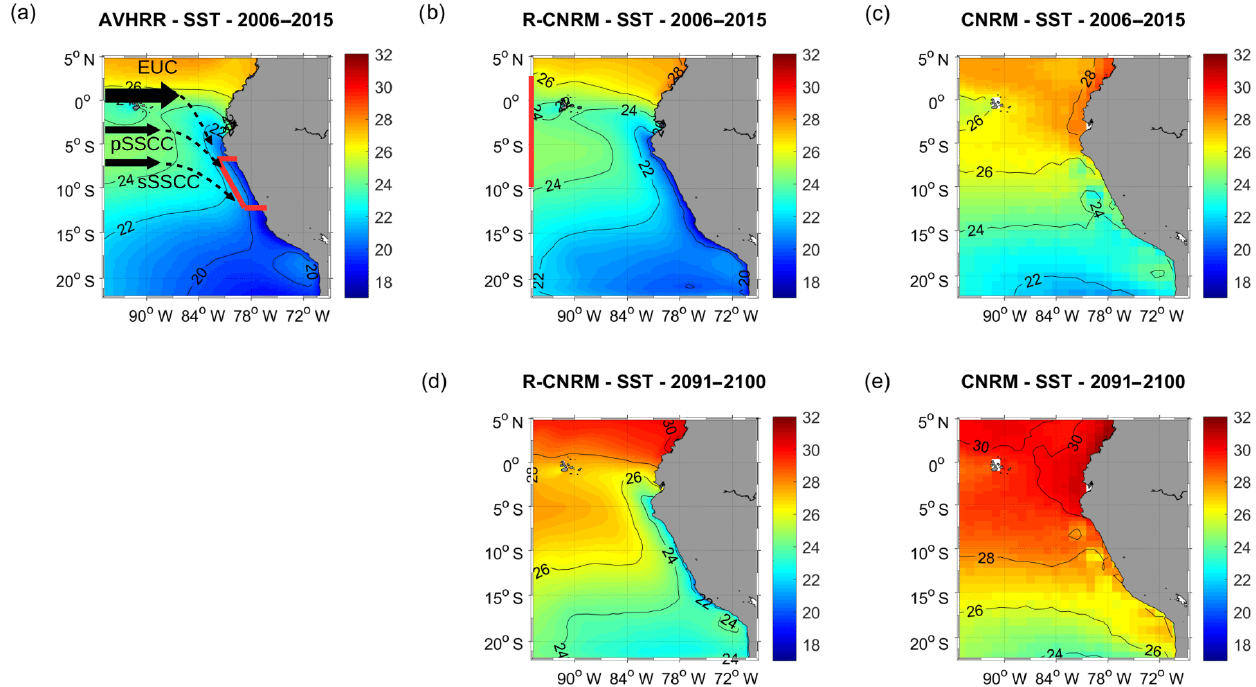
Figure 2. Annual mean SST ( ◦ C) for (a) AVHRR surface observations (2006–2015), (b) R-CNRM (control period, 2006–2015), (c) CNRM (2006–2015), (d) R-CNRM (RCP8.5, 2091–2100), and (e) CNRM (RCP8.5, 2091–2100). The red box in (a) marks the coastal box in which surface and subsurface variables are averaged (see Methodology Sect. 2.8), and the red line in (b) marks the 95 ◦ W offshore section. Subsurface eastward equatorial currents (equatorial undercurrent (EUC) primary and secondary subsurface counter currents (pSSCC and sSSCC)) are sketched in (a)